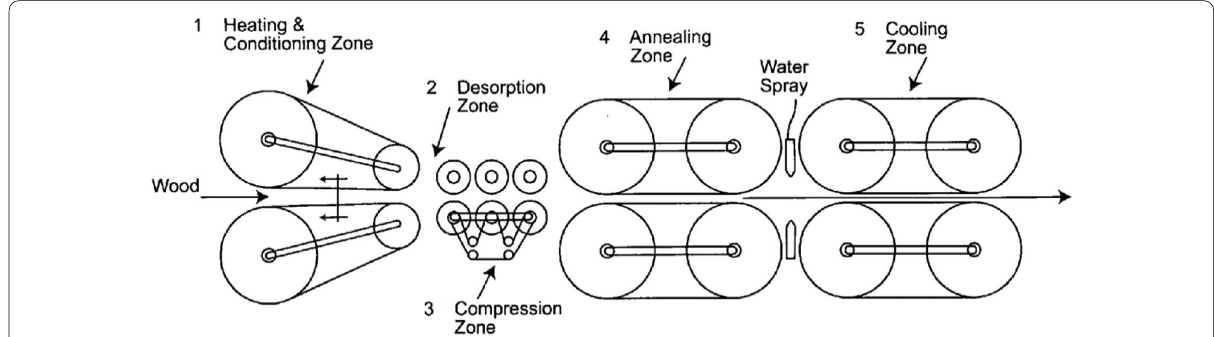
Fig. 5 Continuous VTC densification apparatus